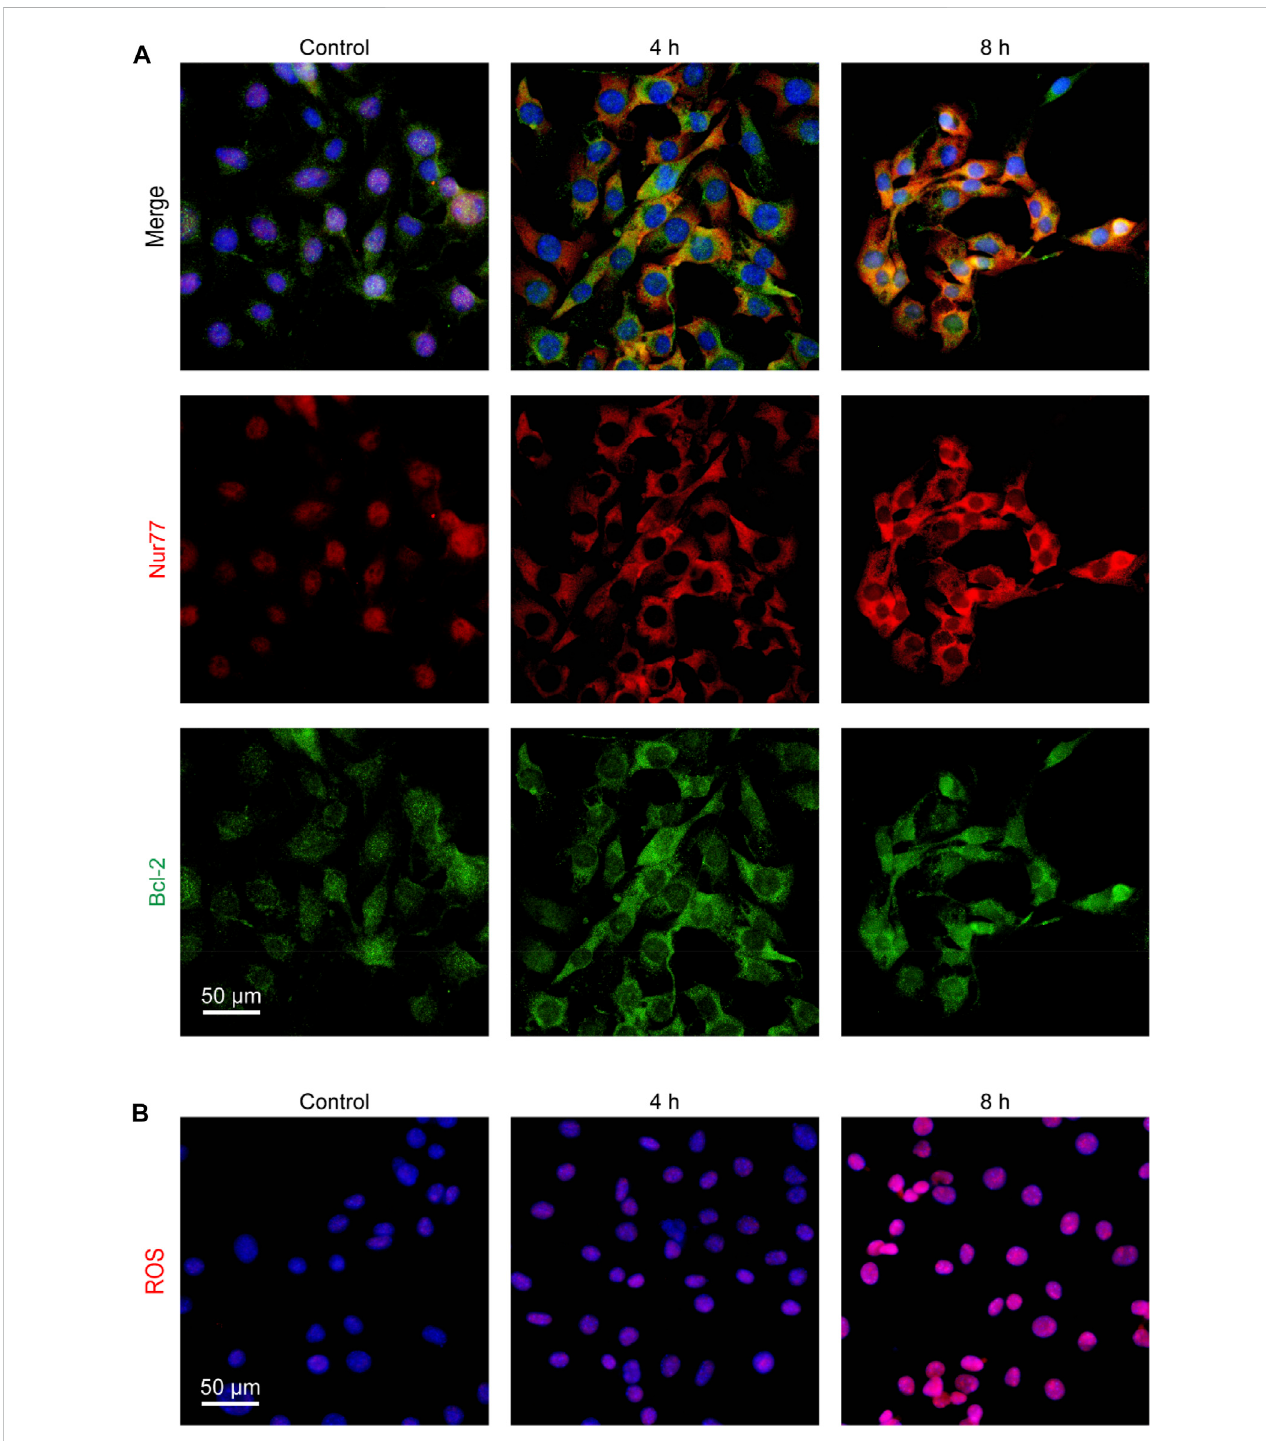
FIGURE 3 Venlafaxine induced Nur77 mitochondrial targeting and ROS production in MV3 cells. (A) MV3 cells treated with venlafaxine (10 μ M) for 0 – 8 h were immunostained with Bcl-2and Nur77 antibodiesandvisualized byconfocal microscopy. (B) MV3 cells treated withthecellularROS assay kitand visualized by confocal